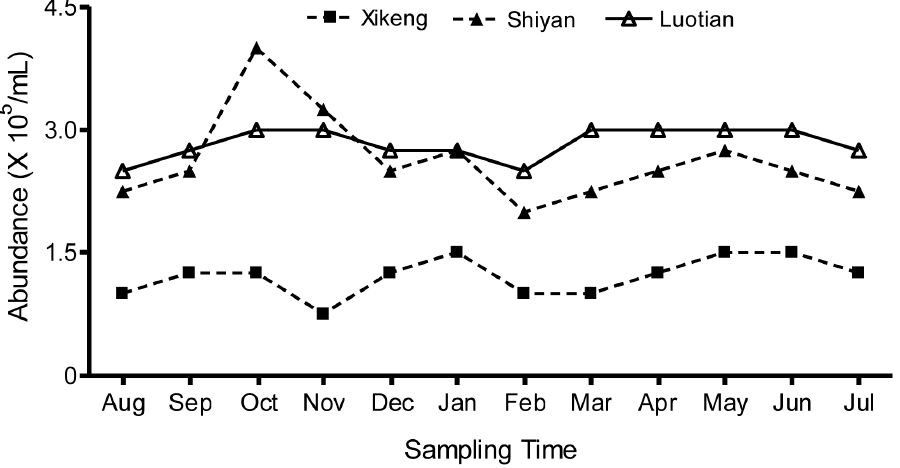
Figure 3. Bacterioplankton abundance in three reservoirs.